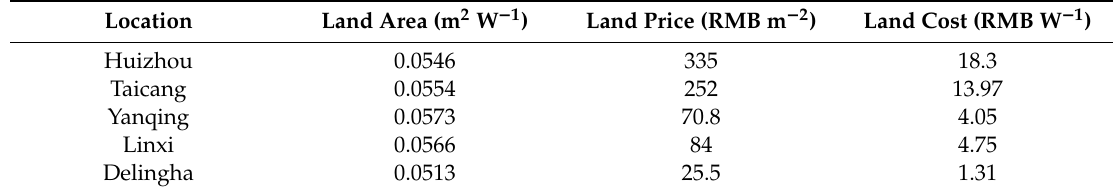
Figure 3. Direct normal irradiation data for China (© 2017 The World Bank, Solar resource data: Solargis). Table 3. Land costs for a tower CSP plant of 100 MW in different locations.